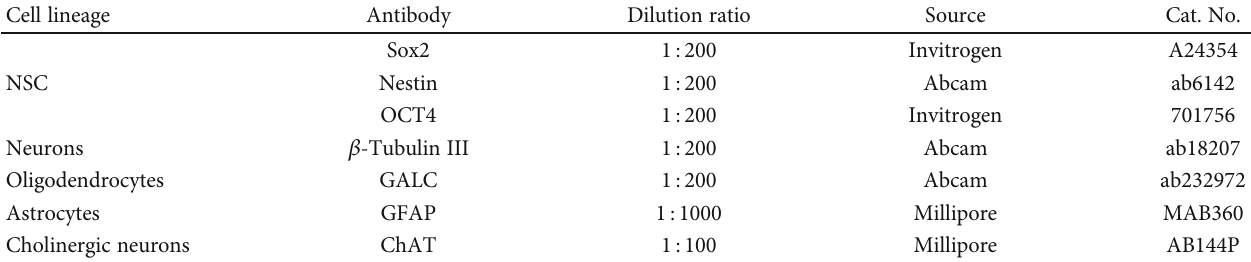
Table 1: Details of primary antibody used for fl uorescent immunocytochemistry.